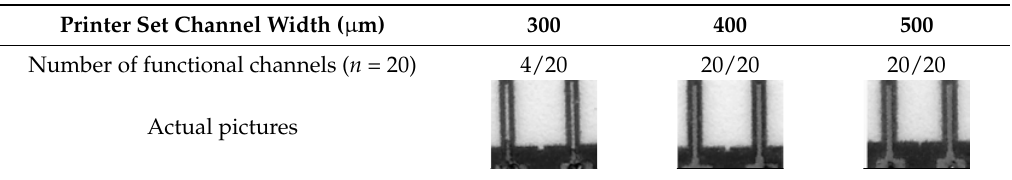
Table 2. Evaluation of narrowest possible printed microfluidic channel width (images converted to grayscale and contrast adjusted for improved visibility).